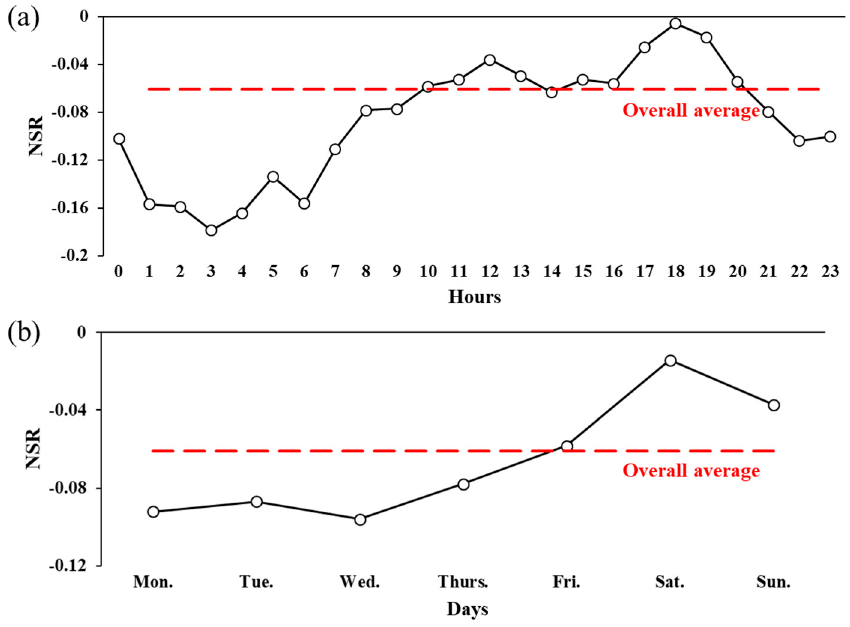
Figure 6. NSR s by ( a ) hours of the day and ( b ) days of the week.